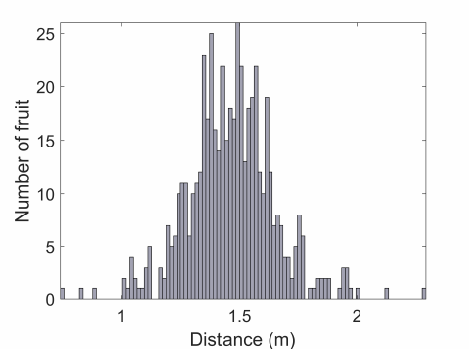
Figure 16. The LiDAR-voxel canopy volumes ( a ) and their relationship to yield ( b ) for all trees. Almost no relationship was observed between canopy volume and fruit yield.